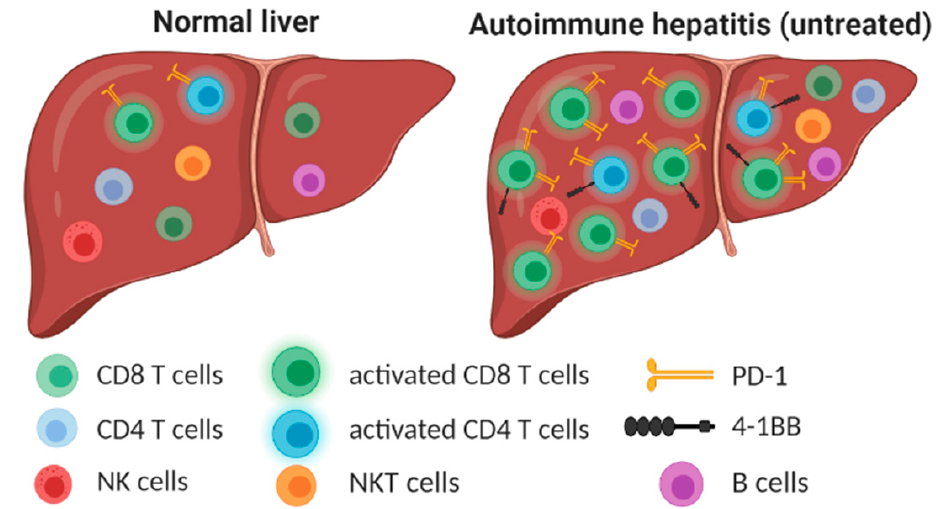
Figure 4. Untreated AIH is characterized by high accumulation of activated T cells with increased expression of PD-1 and 4-1BB immune checkpoint molecules. Created with